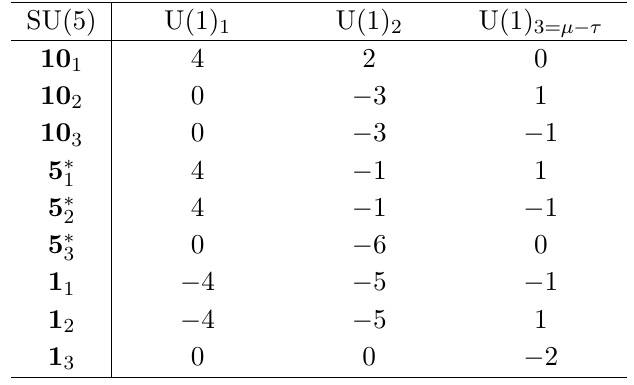
Table 4 . U(1) charges of the NG multiplets in breaking (3.4). The U(1) 1 , U(1) 2 and U(1) 3 are the